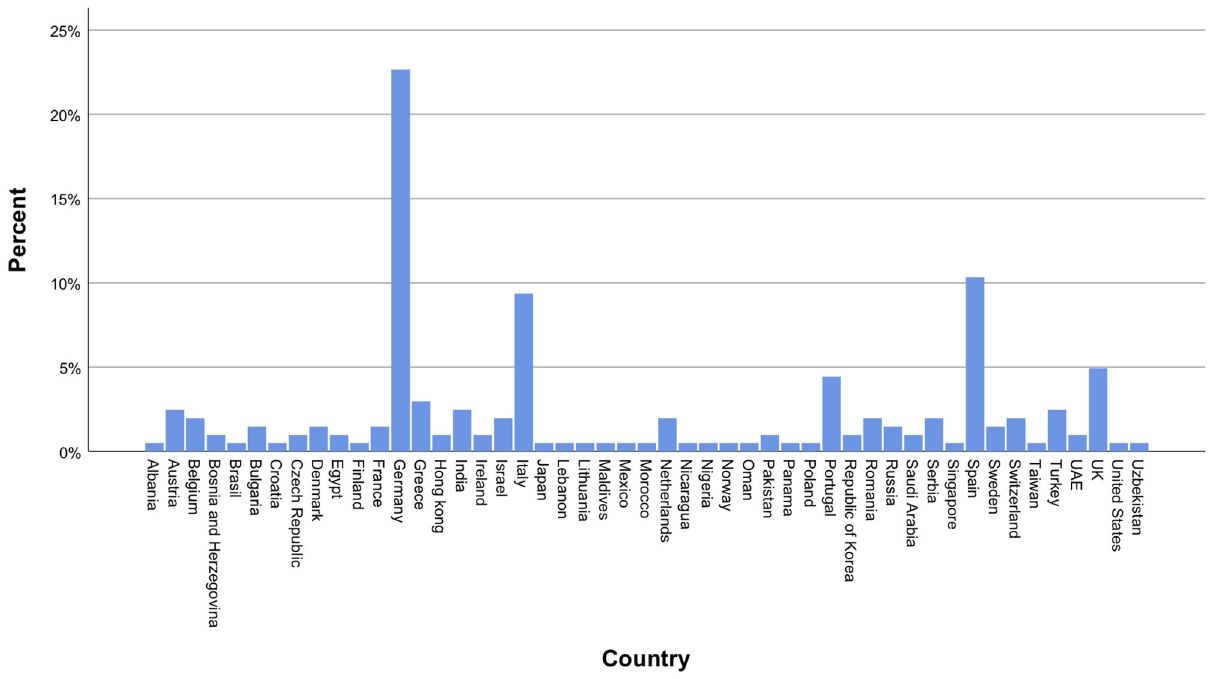
Frontiers in Surgery |